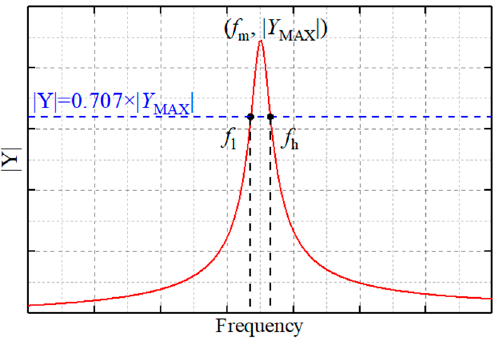
Figure 3. The admittance parameter (Y-parameter) of an MTM slab. The quality factor Q can be calculated from the graph. Take the resonance frequency f m , and get the high limit frequency f h and low limit frequency f l when the amplitude of Y-parameter drops to 0.707 of itself, then Q = f m / ( f h − f l )